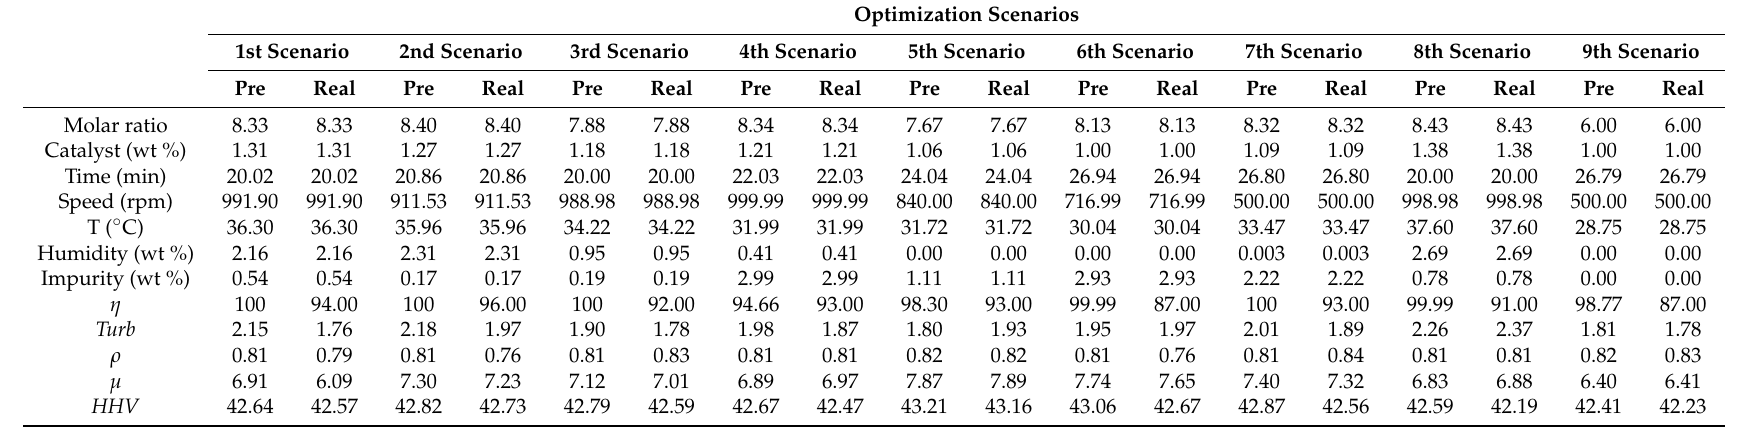
Table 13. Optimization scenarios: Comparison of feature combination for the optimization of the biodiesel process. Pre: predicted values; Real: experimental